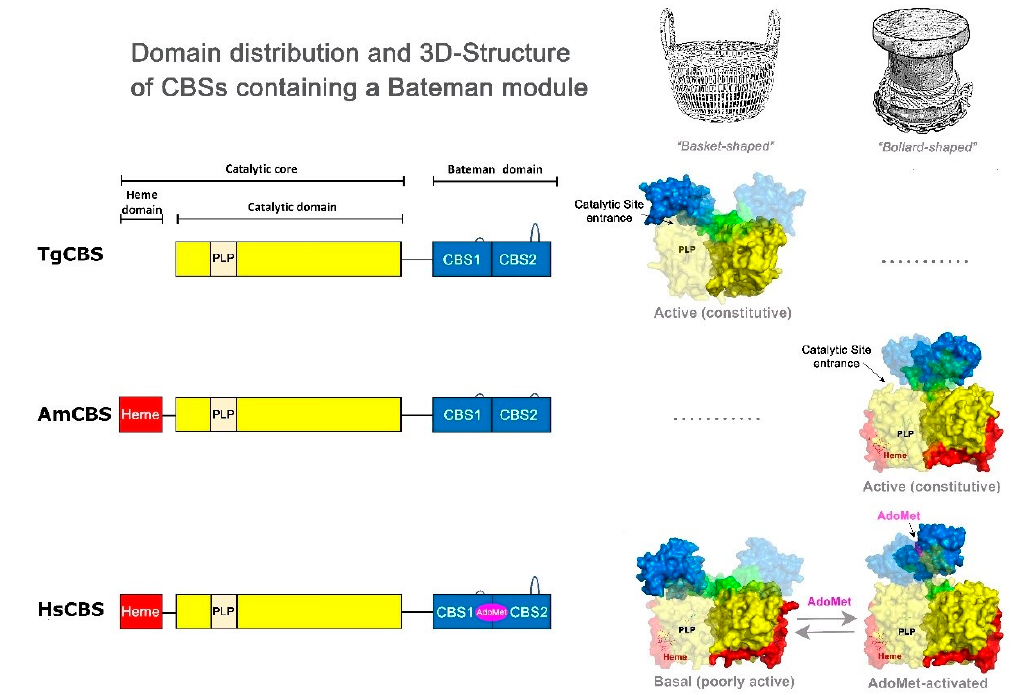
Figure 1. Three-dimensional structure of CBS enzymes containing a Bateman module. Domain distribution in CBSs containing a Bateman module (left). The more complex architecture is found in HsCBS ( bottom ) and contains a N-terminal heme-binding domain (red), a catalytic domain that hosts the PLP cofactor (yellow), and a C-terminal Bateman module (blue) that can host AdoMet (magenta). The interdomain linker is in green. The two complementary subunits of each dimer are represented by opaque and transparent surfaces, respectively. DmCBS or AmCBS contains the same domain architecture found in HsCBS but is not regulated by AdoMet ( middle ). TgCBS lacks the heme-binding domain and is not allosterically regulated by AdoMet ( top ).